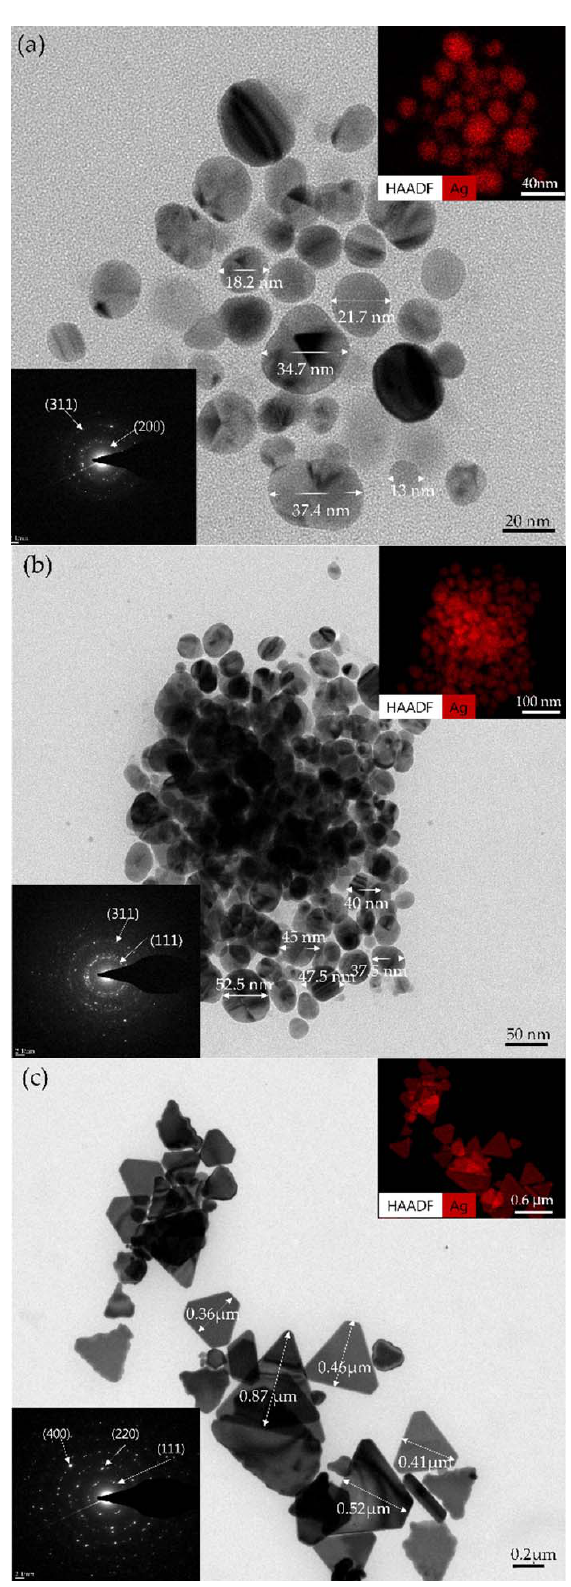
Figure 6. Transmission electron microscopy (TEM) images in ( a ) case I, ( b ) case II, and ( c ) case III. Top-right corner insets in ( a – c ) are energy dispersive X-ray spectroscopy (EDS). Bottom-left corner insets in ( a – c ) are selected area electron diffraction (SAED) patterns of synthesized Ag NPs for three cases.